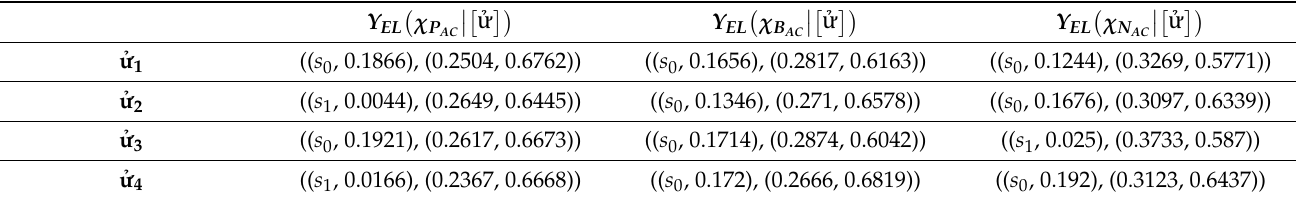
Table 4. Expected losses from the aggregated values of Table 3.